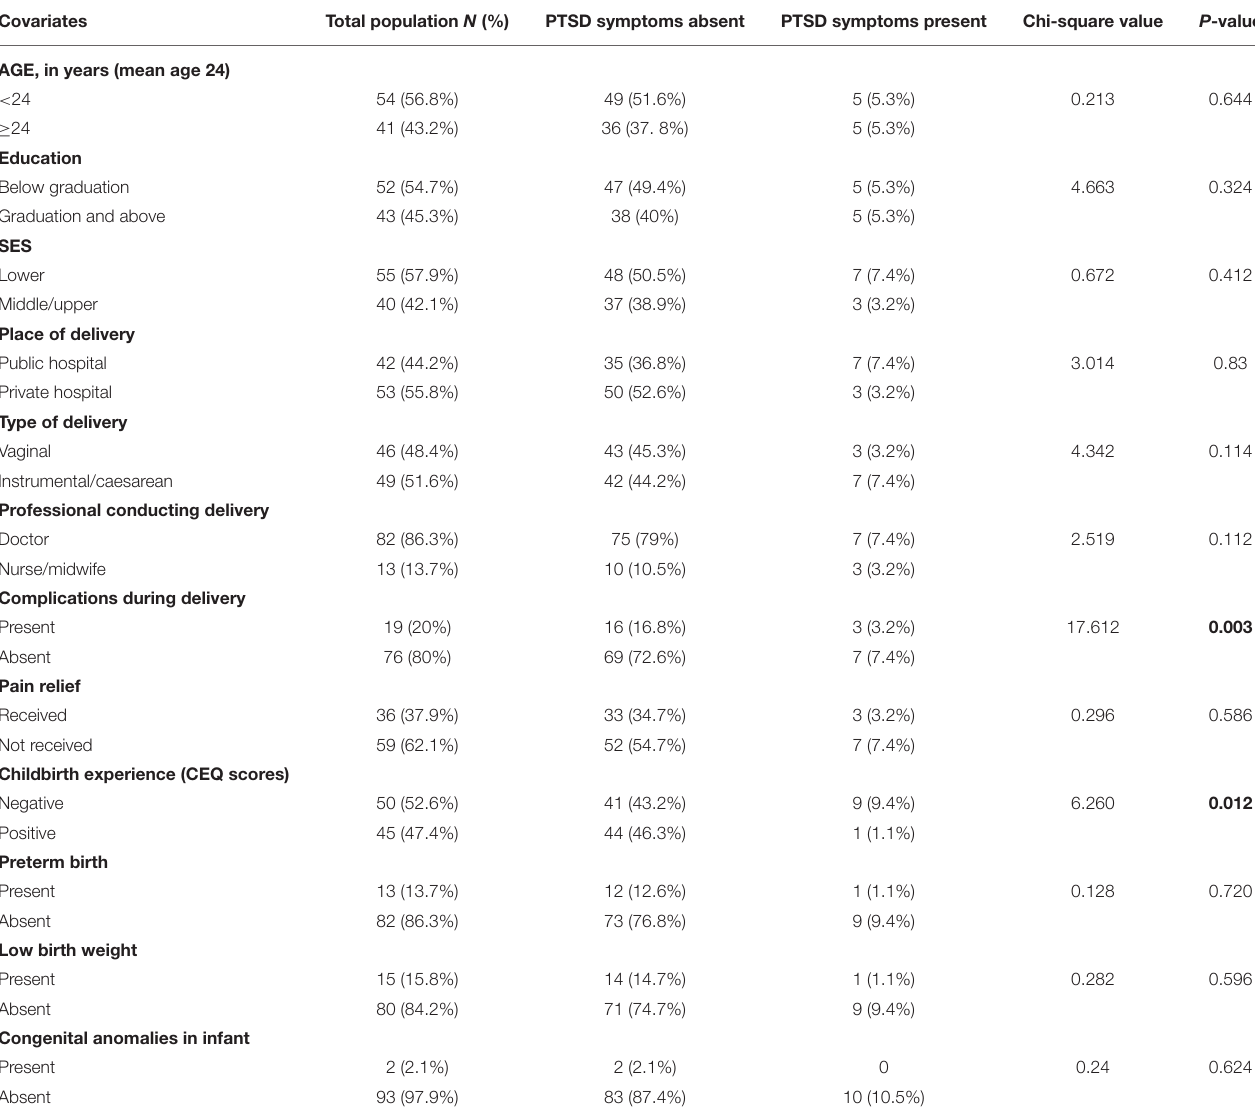
TABLE 1 | Factors associated with PTSD – Univariate analysis. Covariates Total population N (%) PTSD symptoms absent PTSD symptoms present Chi-square value P